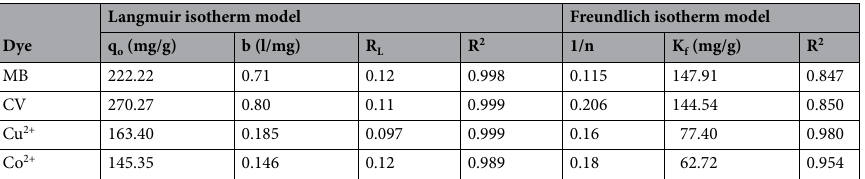
Table 2. Langmuir and Freundlich constants for adsorption of MB-dye (t = 5 min, Dose = 6 mg, v = 50 ml, pH = 7, T = 30 °C) and CV-dye (t = 7 min, Dose = 6 mg, v = 50 mL, pH = 7, T = 30 °C), Cu 2+ (t = 1 min, Dose = 2.4 mg, v = 5 ml, pH = 6, T = 25 °C) and Co 2+ (t = 1 min, Dose = 2.4 mg, v = 5 ml, pH = 8, T = 25 °C) form aqueous solution.